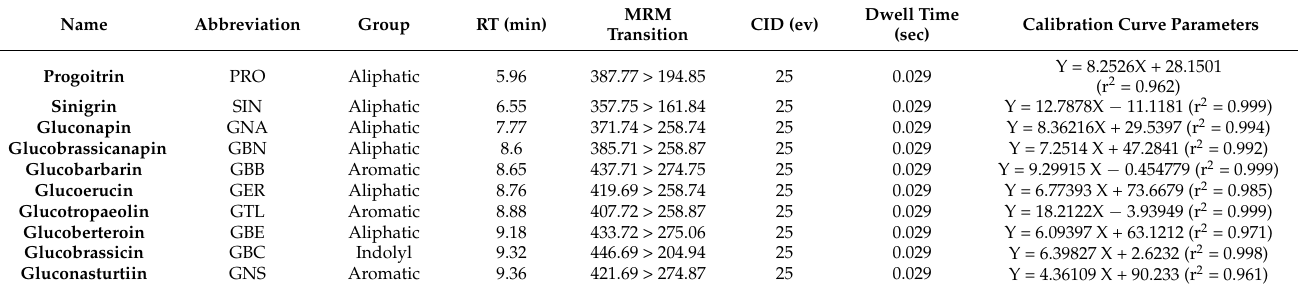
Table 1. UPLC spectroscopy information on ten glucosinolates studied in sixty Chinese